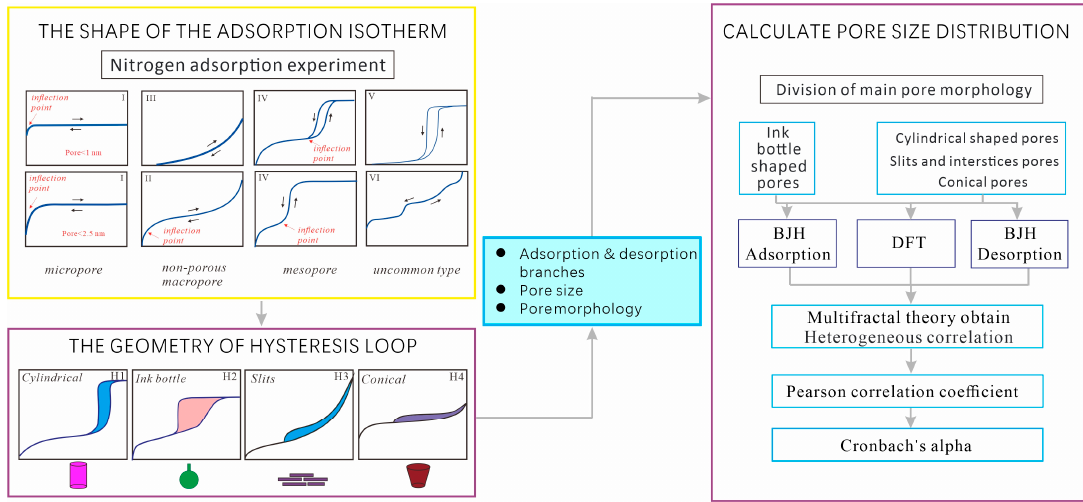
Figure 15. The workflow of the N 2 adsorption selection method for the PSD of the shale.